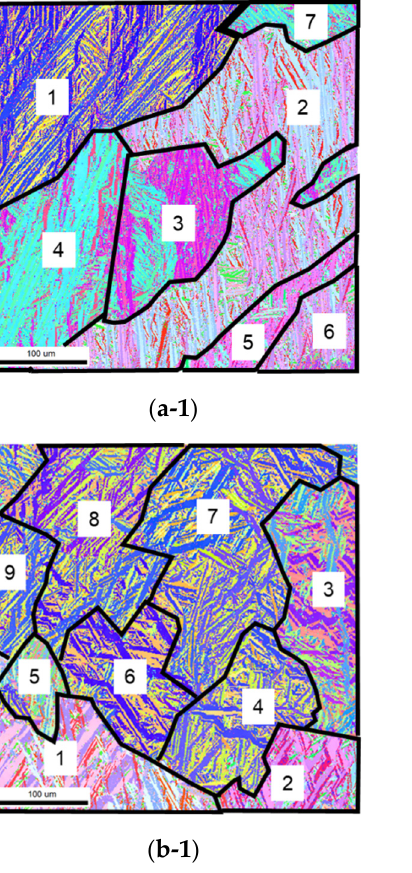
Figure 5. Inverse pole figures and texture plots on the ( a ‐ 1,2 ) A1 direction of the isobaric tested equiatomic TiPd alloy cut in the compression direction and the ( b ‐ 1,2 ) A3 direction of the tested equiatomic TiPd alloy cut in a vertical compression direction.